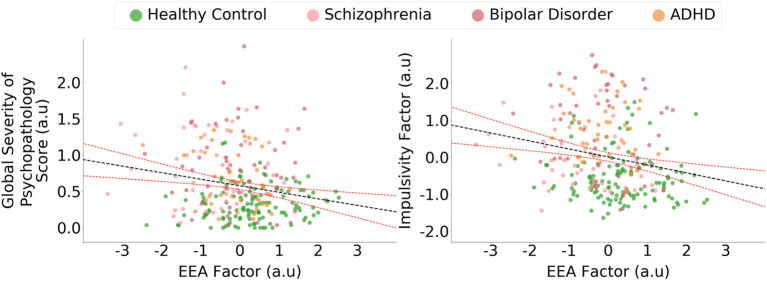
Evidence accumulation is related to global psychopathology and impulsivity. The efficiency of evidence accumulation (EEA) factor was statistically significantly correlated with a global psychopathology severity score derived from a self-report general symptom scale. The evidence accumulation factor was also significantly correlated with an impulsivity factor derived from three self-report scales of trait impulsivity. Confidence intervals represent 95% predictive intervals, a.u., arbitrary units.